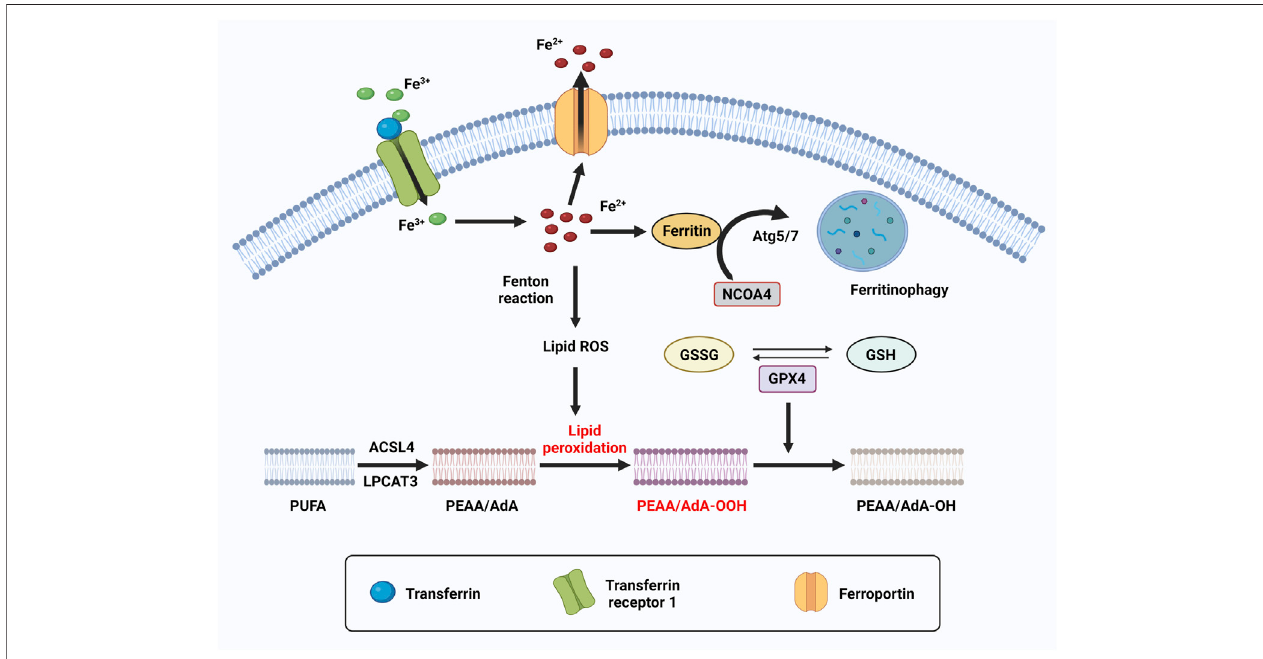
FIGURE 4 | The molecular mechanism of ferroptosis. Ferroptosis is an iron dependent form of cell death. The metabolism of iron includes iron uptake (transferrin receptor), iron export (ferroportin), iron storing (ferritin), and ferritinophagy. Ferritinophagy is a selective autophagy of ferritin which mediated by Atg5/7 and NCOA4. Excess can directly induce ferroptosis through lipid peroxidation. GPX4, converts PEAA/AdA-OOH to PEAA/AdA-OH and inhibits ferroptosis. This reaction occurs through the use of glutathione (GSH) as a